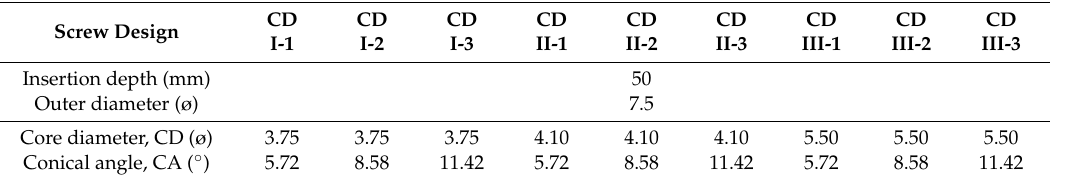
Table 1. Screw design specifications.